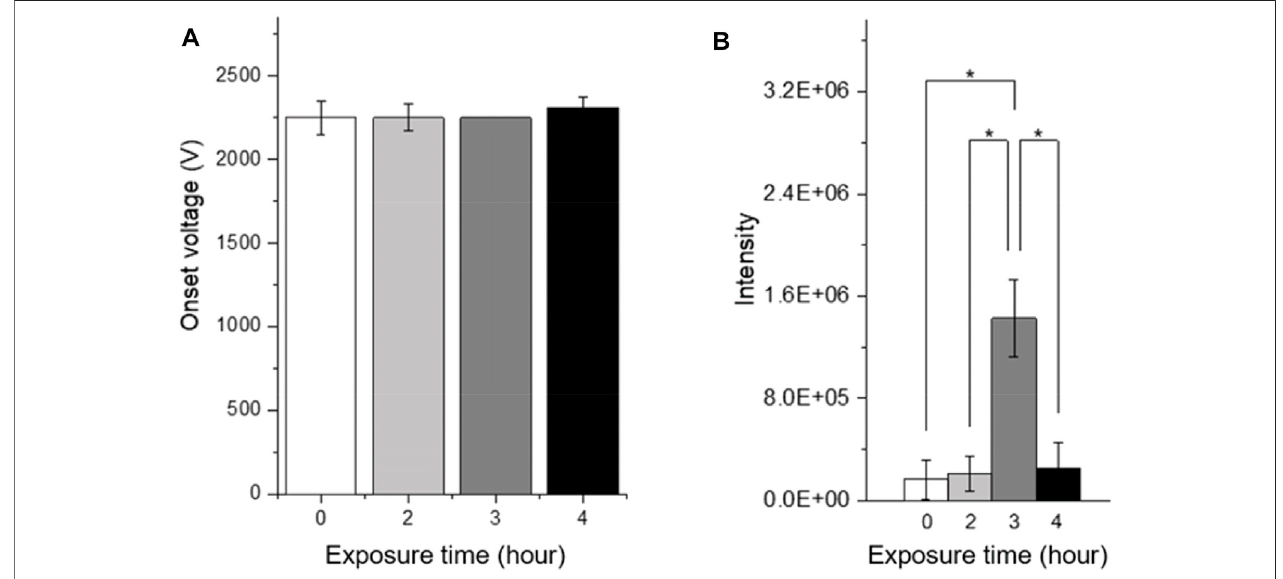
FIGURE 5 | (A) Onset voltage of the single cone-jet and (B) signal intensity of 50 μ g/ml trimethoprim using hydrophobic papers with different exposure time to the silanization reagent.